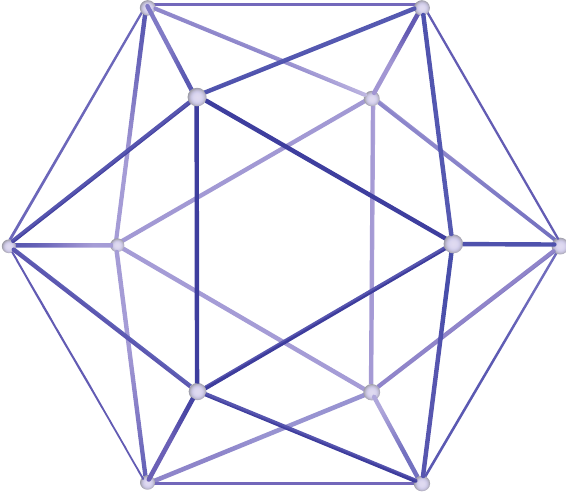
Figure 3: The regular